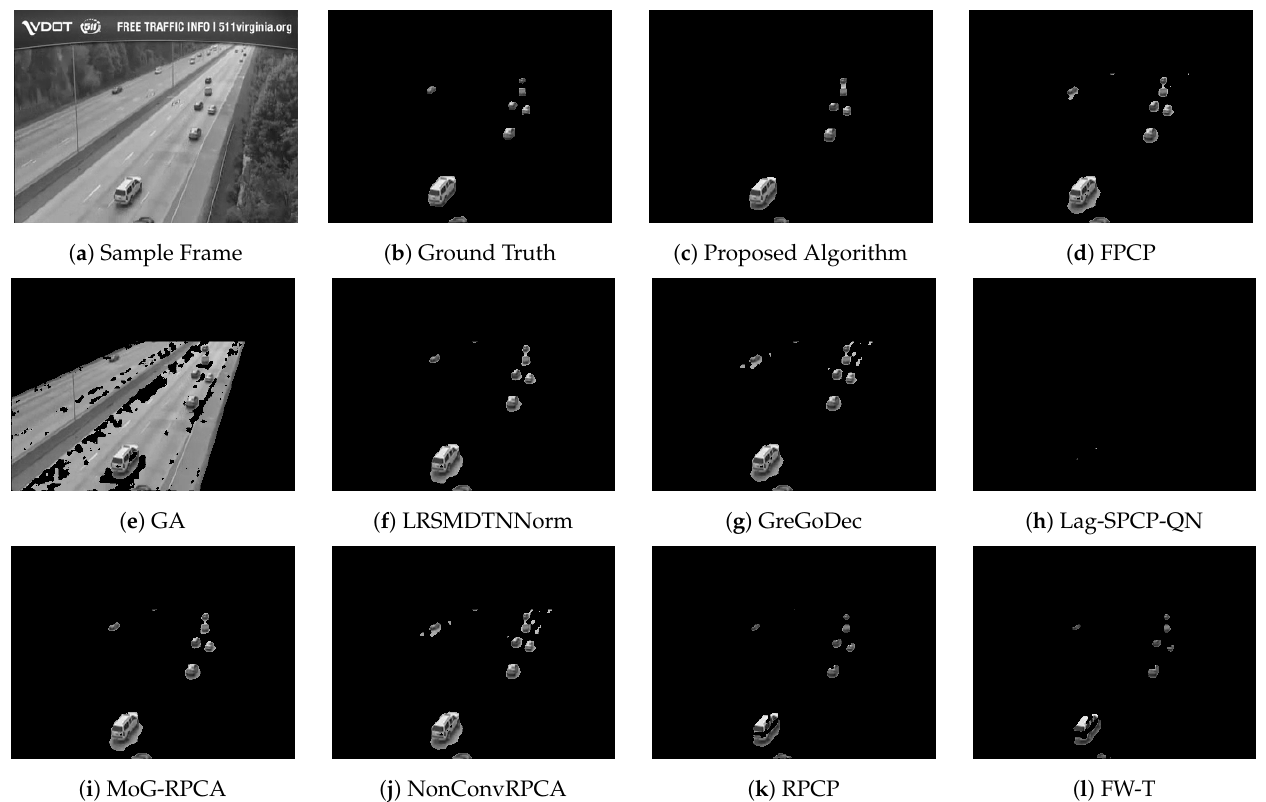
Figure 10. Video 4 segmentation outputs comparison for different segmentation